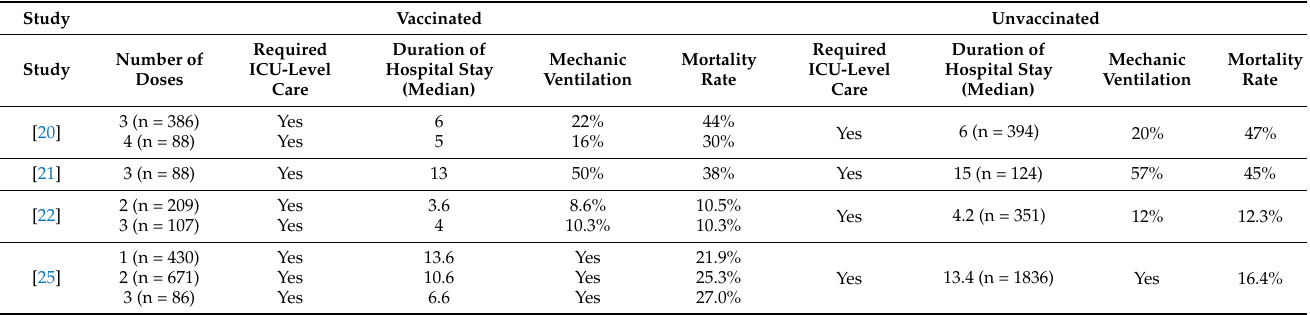
Table 3. Clinical outcomes by vaccination